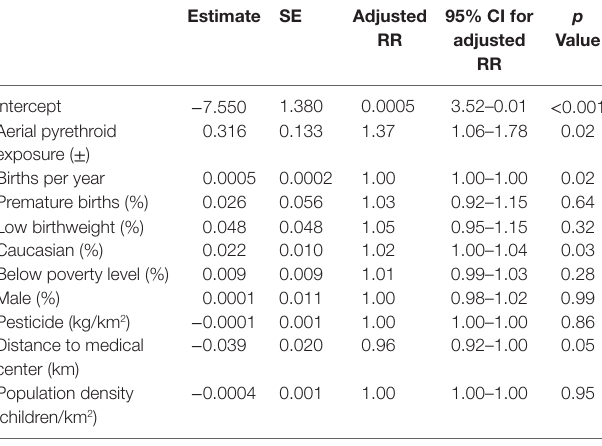
TaBle 5 | Poisson regression analysis controlling for clinically relevant, confounding variables to estimate the direct effect of aerial pyrethroid exposure on asD/DD